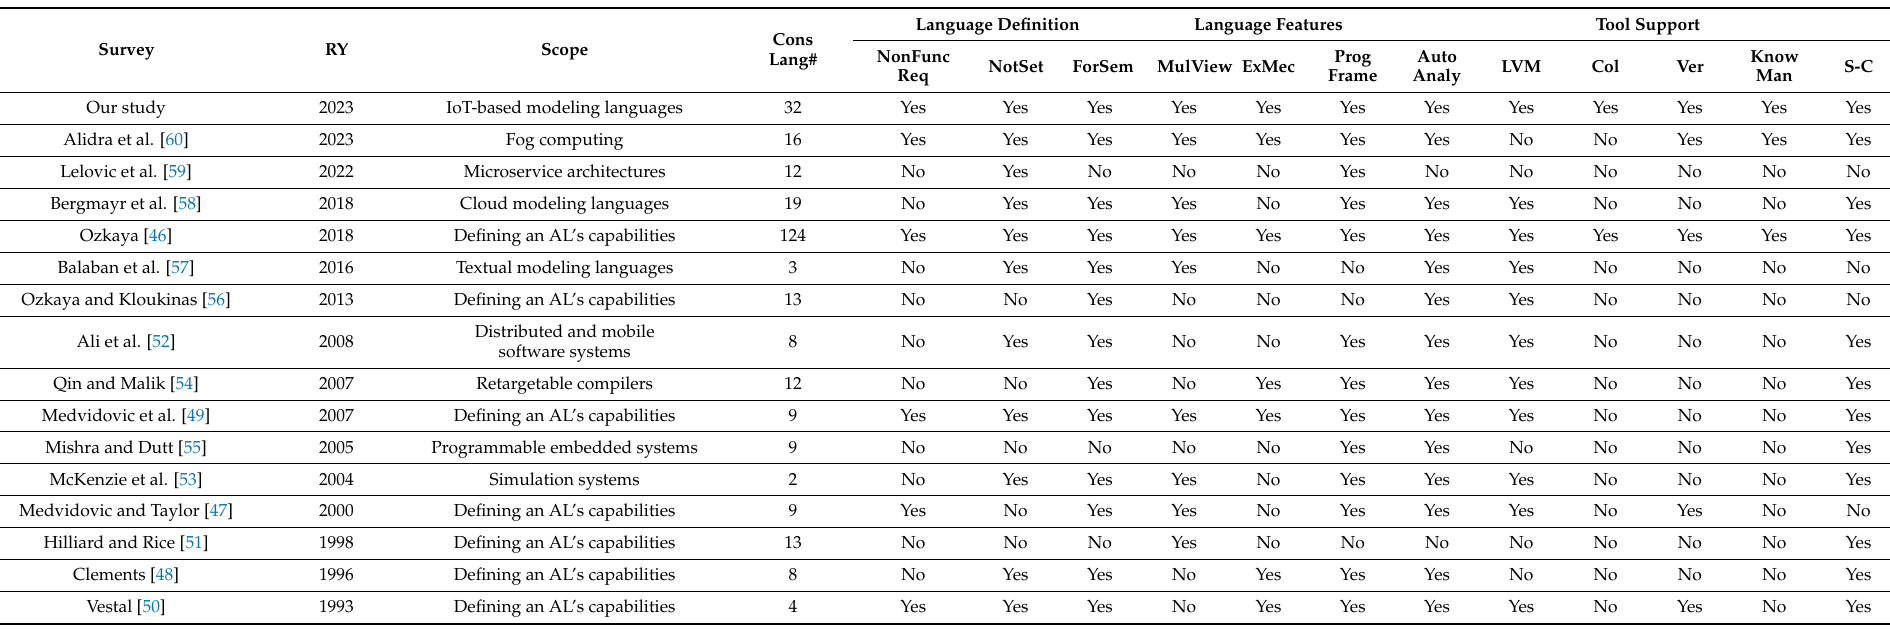
Table 1. The summary of the analysis of the related